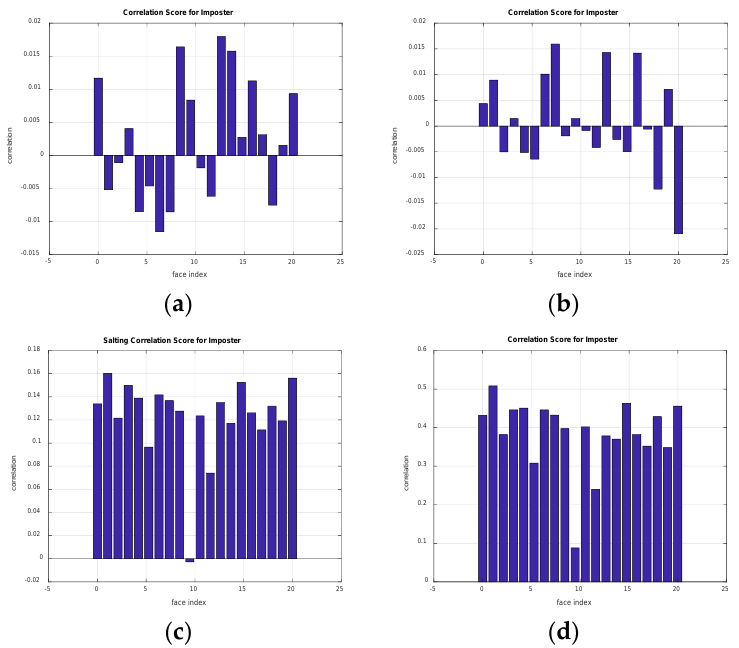
Figure 19. Correlation scores for unauthorised imposter patterns (for FERET dataset) for ( a ) CFR1, ( b ) CFR2, ( c ) homomorphic transform followed by salting and ( d ) homomorphic transform followed by random kernel convolution.